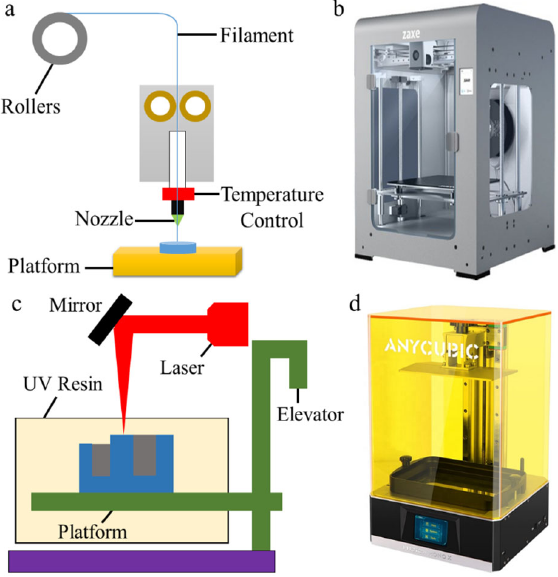
Figure 2. Schematic of the FDM and SLA method: ( a ) FDM fabrication process image; ( b ) FDM ‐ based 3D printer; ( c ) SLA fabrication process image; ( d ) SLA ‐ based 3D printer.